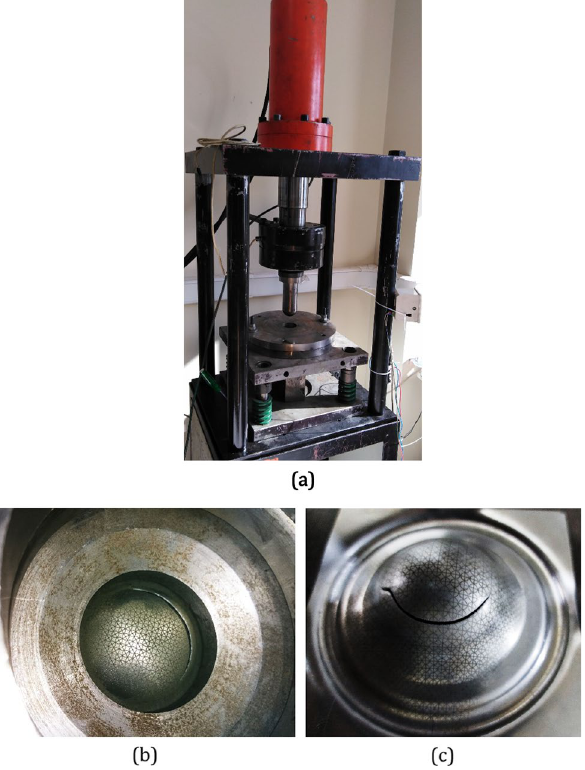
Figure 5. Forming limit determination using hemisphere punch test, ( a ) Test aparatus ( b ) Sample sheet in aparatus in time of fracture, ( c ) The same sample after test.